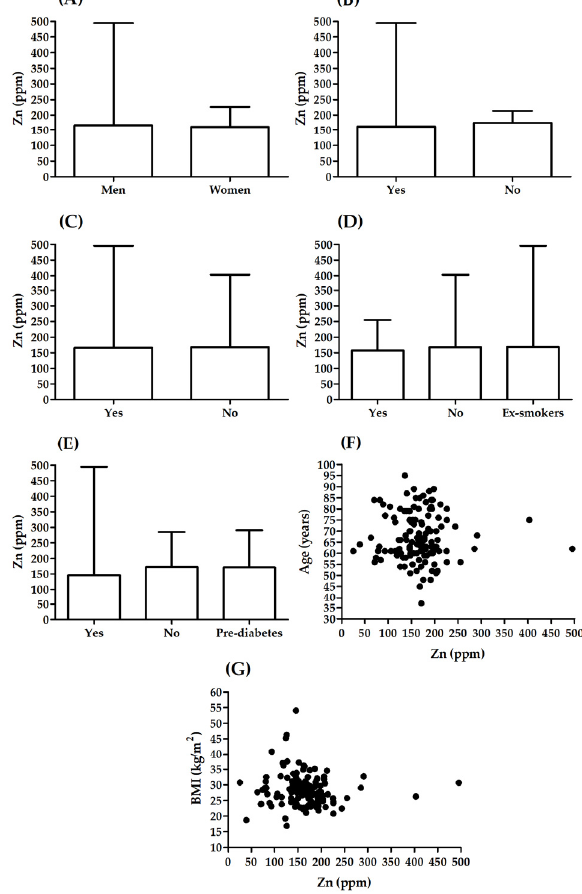
Figure 3. Association between Zn level and selected parameters: ( A ) sex, ( B ) hypertension, ( C ) hyperlipidaemia, ( D ) smoking status, ( E ) t2DM, ( F ) age, ( G ) BMI.